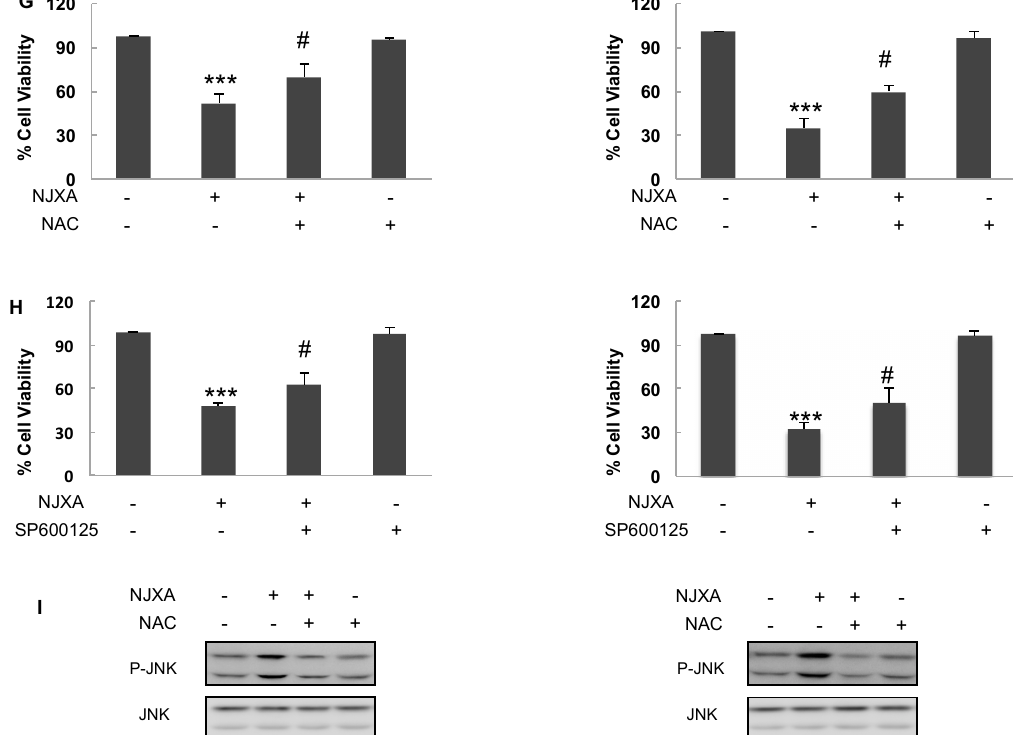
Figure 4. NJXA activates the ROS/JNK pathway in HeLa and SiHa cells. ( A ) HeLa or ( B ) SiHa cells were treated with NJXA (0~20 μ M) for 12 h. The cells were incubated with DCFH-DA and were observed under a fluorescence microscope ( upper panel ) or were collected and were analyzed using flow cytometry ( lower panel ); ( C ) HeLa or ( D ) SiHa cells were treated with NJXA (0~20 μ M) for 24 h or 48 h, and their p-JNK levels were then analyzed by Western blotting; ( E ) HeLa or ( F ) SiHa cells were pretreated with 10 mM of NAC for 2 h and then were incubated with DMSO or 20 μ M of NJXA for 12 h. The cells were treated with DCFH-DA and were observed under a fluorescence microscope ( upper panel ) or were collected and were analyzed using flow cytometry ( lower panel ); ( G ) HeLa ( left panel ) or SiHa ( right panel ) cells were treated with NJXA (20 μ M) for 48 h after pretreatment with NAC (10 mM) for 2 h. Cell viability was measured by MTT assay; ( H ) HeLa ( left panel ) or SiHa ( right panel ) cells were treated with NJXA for 48 h after pretreatment with SP600125 (20 μ M) for 2 h. Cell viability was (measured by MTT assay. The data shown are the mean values ± SD. *** p < 0.001 compared with the control, # p < 0.05 compared (with NJXA. n = 3; ( I ) Western blotting analysis for protein expression of phospho-JNK and JNK was measured in HeLa ( left panel ) or SiHa ( right panel ) treated with NJXA after pretreatment with NAC (10 mM) for 2 h.